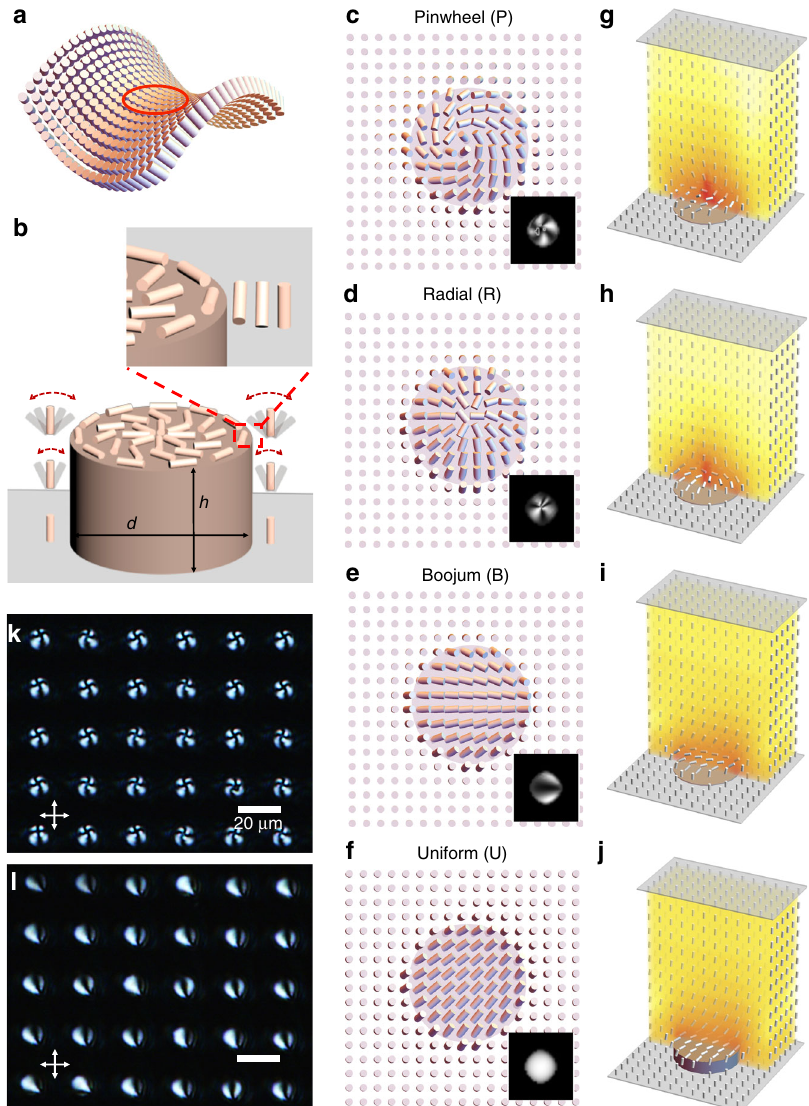
Fig. 1 Liquid crystals on circular posts. a Distorted director fi eld with saddle-splay rich region indicated in red. b Schematic of director reorientation over the top of a post. Liquid crystal is increasingly free to reorient with post height above the surface. c – j Stationary liquid crystal con fi gurations with horizontal sections through the director fi eld at the top of the post ( c – f ), simulated polarized optical microscope images (insets) and three dimensional reconstructions ( g – j ) colored by energy density. Post height is h ¼ 0 : 2 μ m for ( c – e ), and h ¼ 2 μ m for ( f ). k , l Experimentally observed pinwheel and boojum structures in 5CB (4-cyano-4 ′ -pentylbiphenyl),